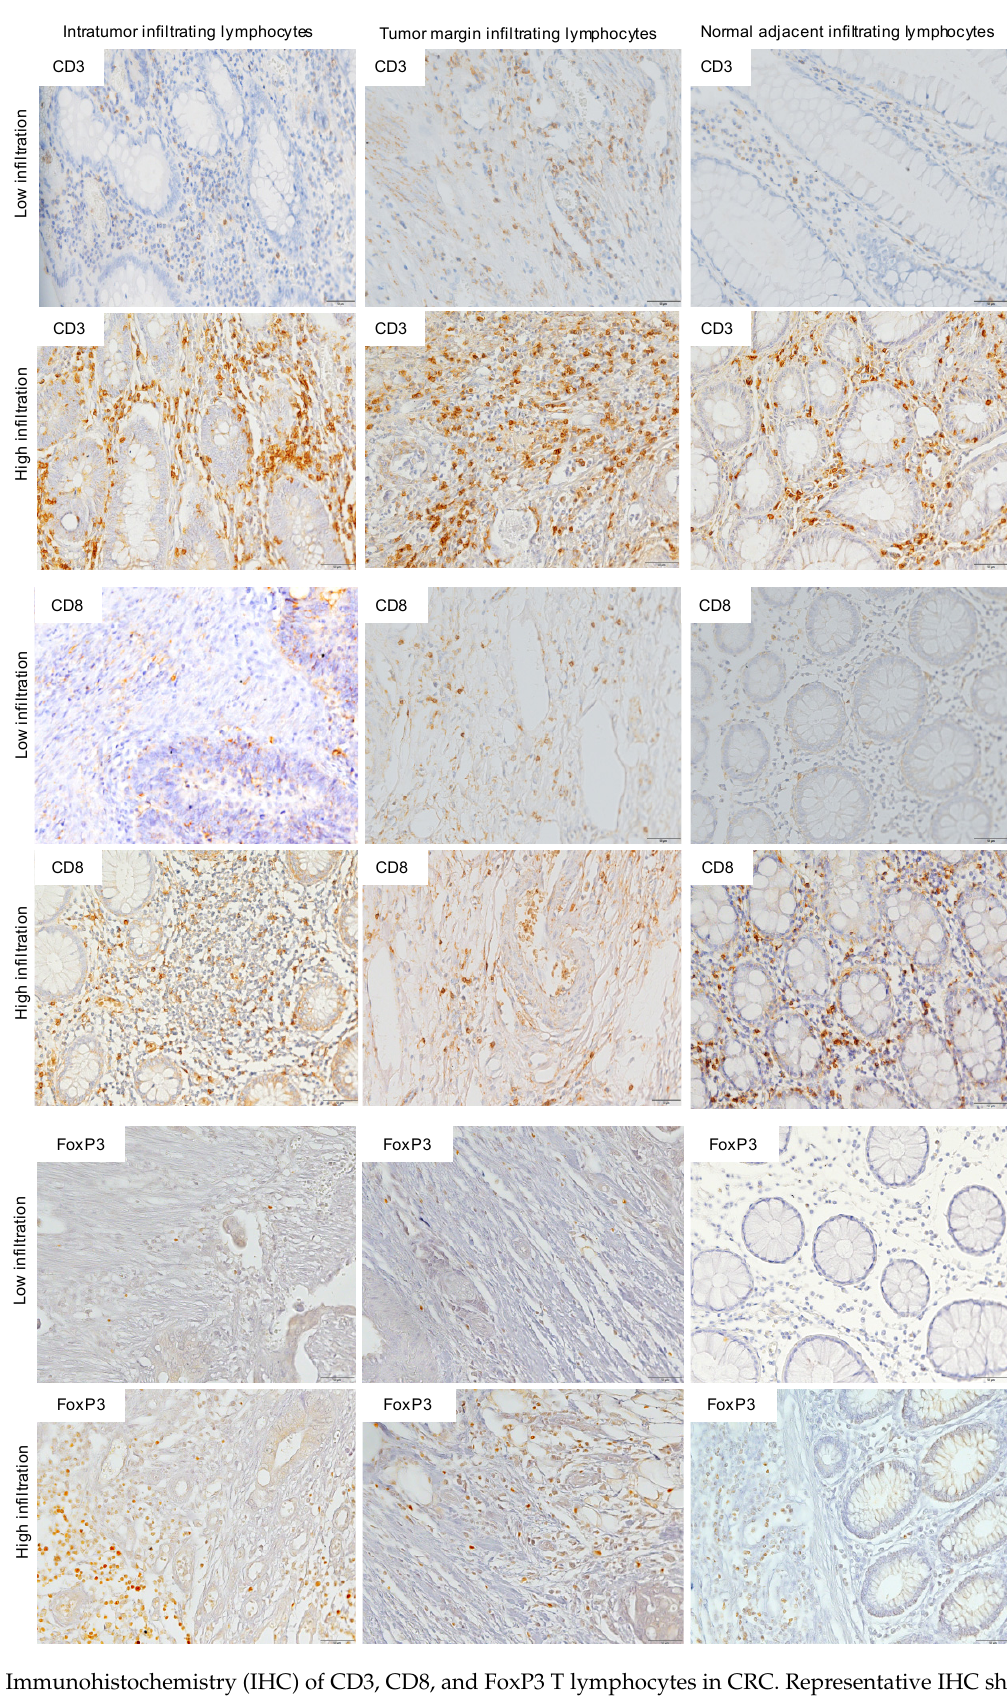
Figure 1. Immunohistochemistry (IHC) of CD3, CD8, and FoxP3 T lymphocytes in CRC. Representative IHC showing low and high CD3 + , CD8 + , and FoxP3 + T lymphocytes densities. Magnification: 200 × .